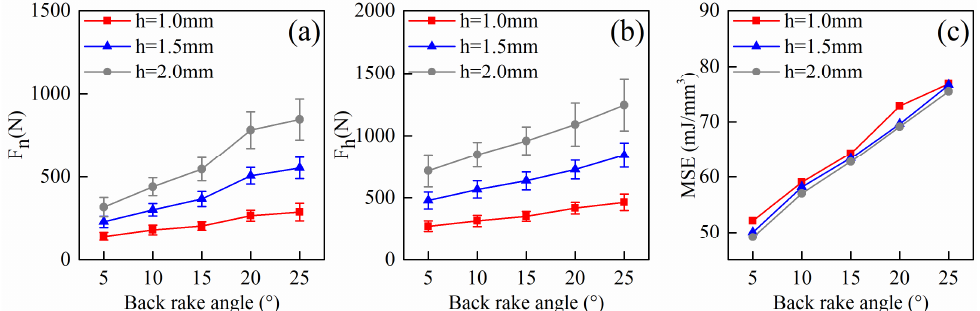
Figure 12. Effect of back-rake angle on: ( a ) F n ; ( b ) F h ; ( c ) MSE.